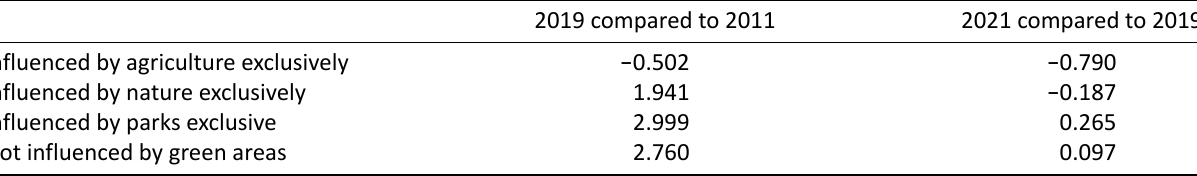
Table 2. Average changes in the residential price rank for subsets of residential